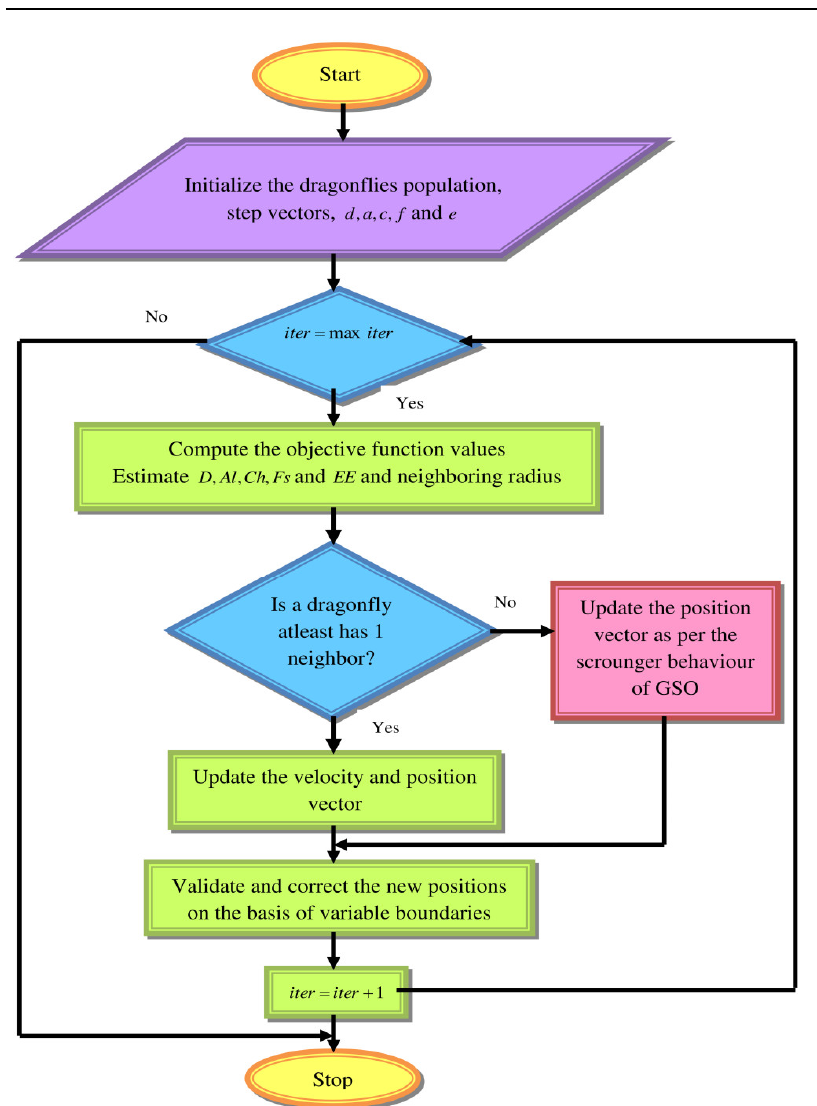
Figure 7. Flowchart of proposed SL-DA algorithm.